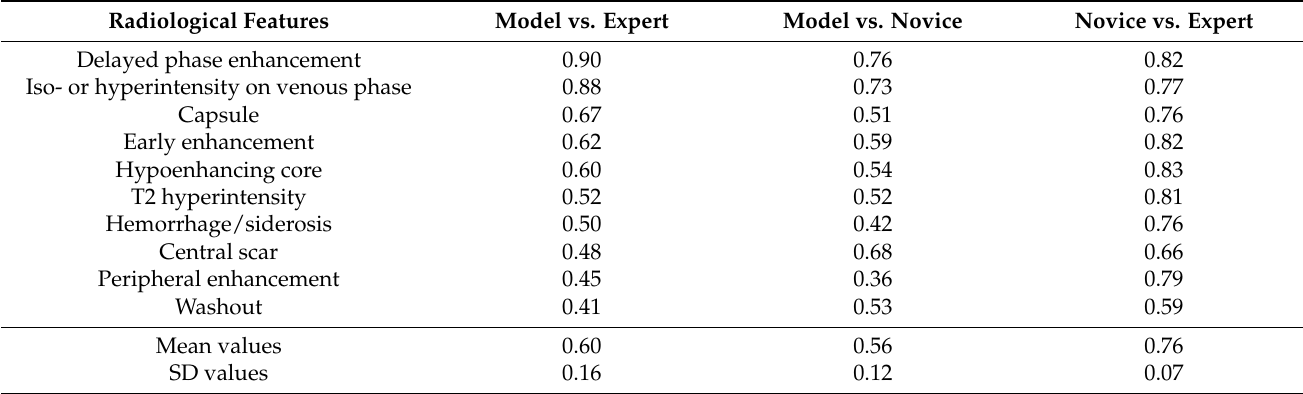
Table 8. Interobserver agreement between the three observers, measured by Cohen’s